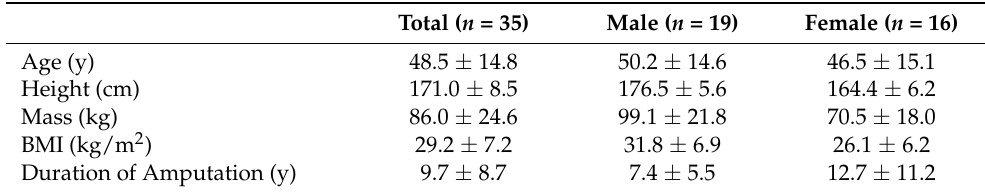
Table 1. Participant